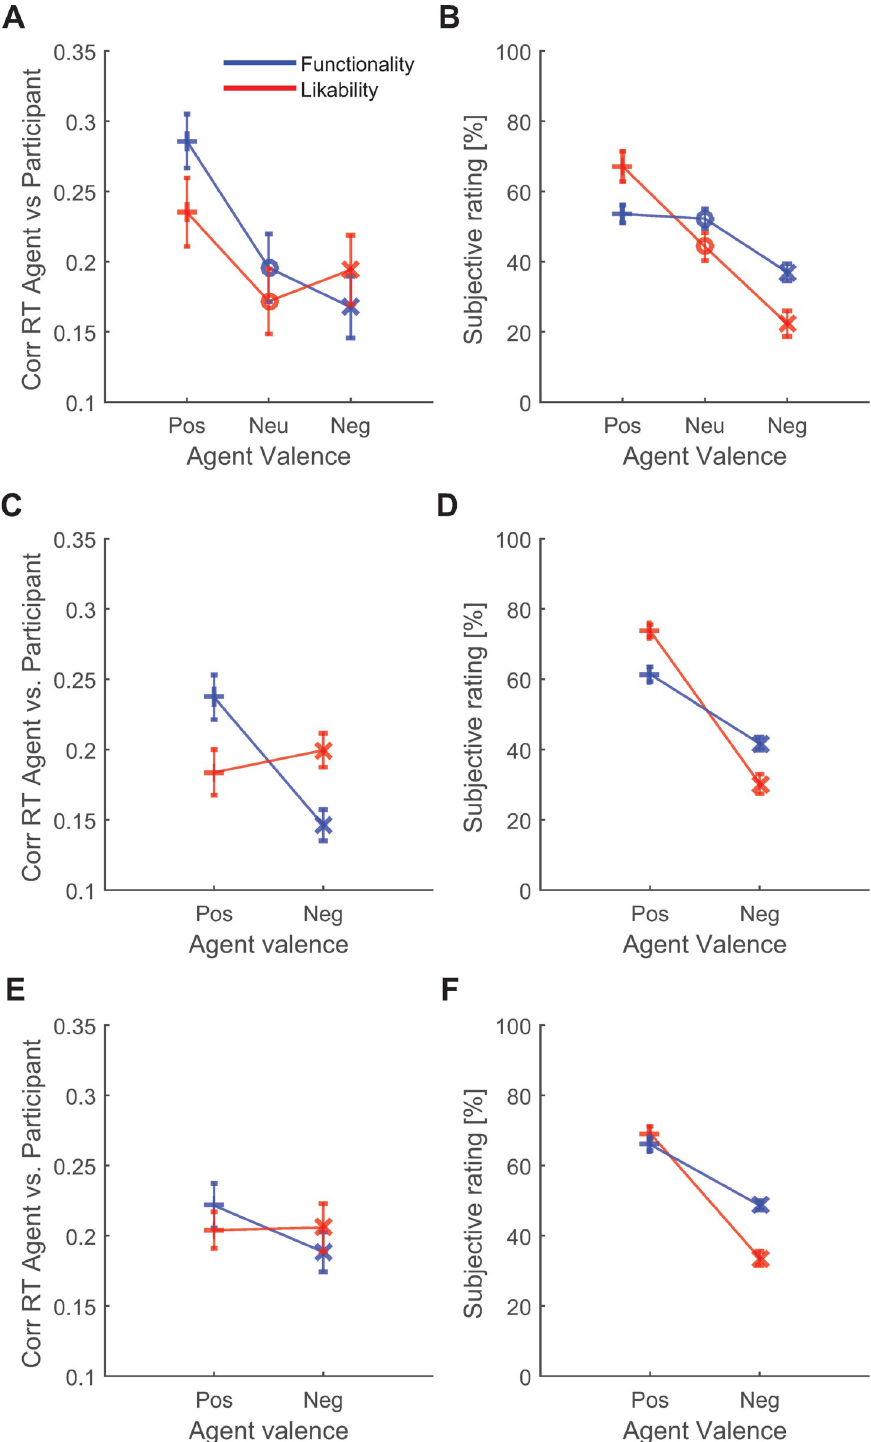
Fig 2. Experiment 1 results. The correlations (Corr) of reaction times (RT) between agents and participants were largest when participants played with a functional (blue line; Pos = positive) agent and were weakest when participants played with a dysfunctional agent in experiment 1 (Neg = negative; Neu = neutral) agent (A). We observed no difference between likable and dislikable agents (red line). Subjective ratings by participants confirmed that they were aware of the differences in functionality and likability across agents (B). Similar patterns of correlations (A) and subjective ratings (B) across agents were present in experiment 2 (C, D) and experiment 3 (E, F).